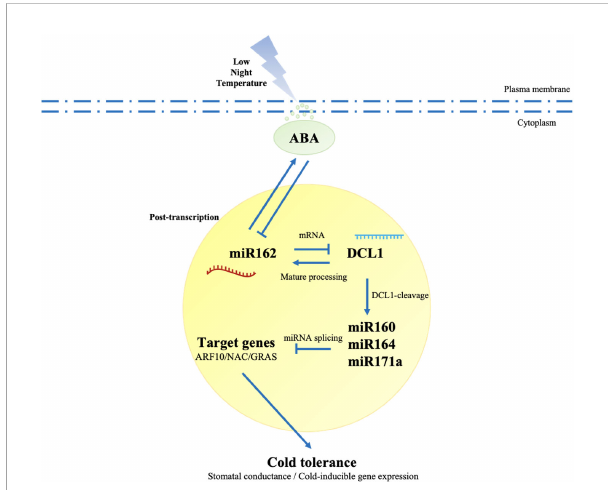
FIGURE 6 miR162-mediated DCL1 cleavage regulated cold tolerance with the ABA-dependent signaling patfway in tomato. Under LNT stress, ABA was activated to mediate multiple responses of tomato plants, including the negative regulation of miR162. Post-transcription was a crucial process in response to environmental stress. miR162 inhibited DCL1 cleavage by targeting the mRNA of DCL1. In DCL1 cleavage, DCL1 mediated miRNAs (miR160, mIR164, and miR171a) and their targets (ARF10, NAC, and GRAS) to regulate the expression of cold-inducible genes and stomatal movement under LNT stress. DCL1 is in the processing of mature miRNAs, including mIR162, which provides feedback to the ABA signaling pathway, so tomato plants resist LNT stress and maintain equlibrium. Sold lines represent regulatory links overserved in the network. Arrows indicate positive regulation, and blunt-ended bars indicate inhibition. A line does not necessarily represent unique or direct regulation by miR162 In the post-transcriptional process in cold stress